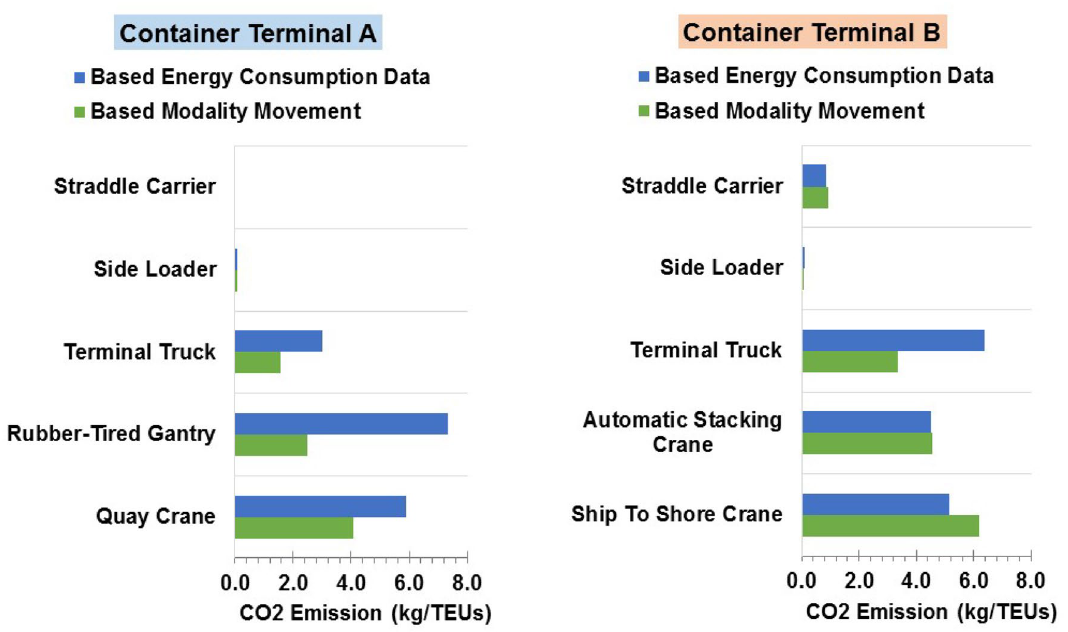
Figure 8. Comparison between CO 2 emissions arising out of container-handling equipment built upon energy use data and those based on movement